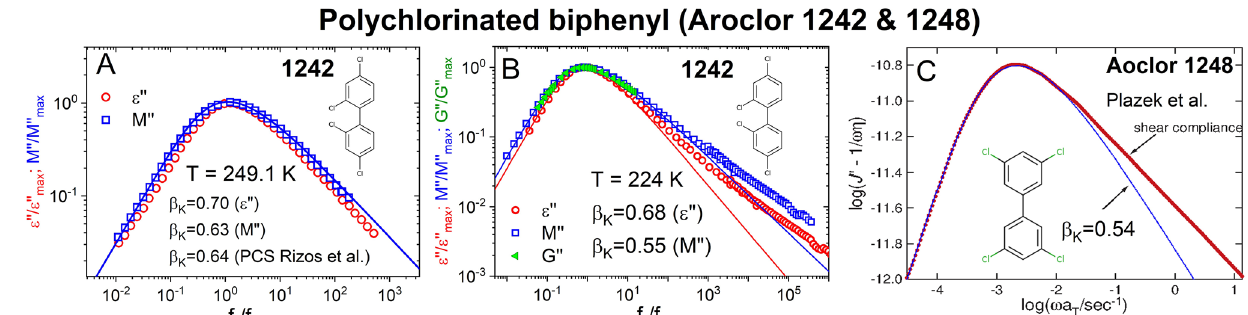
Figure 3. ( A ) Shows the normalized ε ″ ( f ) and M ″ ( f ) vs. normalized frequency of Aroclor 1242 at a higher temperature of 249.1 K. The exponents β DS K = 0.70 and β M K = 0.63 from the Kohlrausch fits are compare with β PCS K = 0.64 from PCS data from Rizos et al. 43 at about the same temperature. ( B ) Compares the frequency dispersions of the normalized ε ″ ( f ), M ″ ( f ) and G ″ ( f ) at a lower temperature of 224 K. The exponents from the Kohlrausch fits are β DS K = 0.68 for ε ″ ( f ), and β M K = 0.55 = β G K the same for M ″ ( f ) and G ″ ( f ). ( C ) Shows the imaginary part of the complex dynamic compliance (red line), J " − 1 /ωη , fitted by the Fourier transform of the J J G M Kohlrausch function with β K and β K = K = 0.54 (blue line) 42 . There is good agreement of β K = 0.54 with β β DS K = 0.68 at 224 K, and 0.70 at 249.1 K. The corresponding electric modulus M ″ ( f ) loss peak becomes broader as shown by comparing with ε ″ ( f ) after normalizing by the maxima and compensating the shift of M ″ ( f ) to higher frequencies. The values of β M K for M ″ ( f ) is 0.55 at 224 K, and 0.63 at 249.1 K (see Fig. 3A). Newly acquired shear modulus data of G ″ ( f ) at 224 K are included in the lower panel to show the α-frequency dispersion is the same as M ″ ( f ) and the Kohlrausch exponents β G K and β M K are equal to 0.55. Thus the broadening seen in G ″ ( f ) is explained by the decrease of the relaxation strength of the α-relaxation relative to the JG β-relaxation. Plazek et al. 42 made shear recovery compliance J r ( t ) measurements of Aroclor 1248 having a slightly higher molecular weight than Aroclor 1242 and T g two degrees higher. From the measurements, the complex dynamic compliance was computed. The imaginary part, J " − 1 /ωη , shown in Fig. 3C is fitted by the Fourier transform of the Kohl- rausch function with β J K = 0.54. The agreement of β J K = 0.54 with β G K and β M K = 0.53 indicates that mechanical spectroscopies (employing either the modulus or compliance modes) broaden the α-relaxation in the same way. PCS was performed by Rizos et al. 43 on Aroclor 1242 at temperatures near 249.1 K and higher but not at lower temperatures. The value of β PCS K reported is 0.64 and temperature independent, which is practically the same as 0.63 for β M K and we made this clear in Fig. 3. The agreement between β PCS K and β M K is like that found in Fig. 2 for PDE. It indicates that the broadening of the α-relaxation seen in dielectric permittivity when probed by PCS is due to a decrease of the relaxation strength of the α-relaxation relative to the unresolved JG β-relaxation close by, enabling the latter to broaden the frequency dispersion of the former. Tributyl phosphate (TBP). The family tributyl phosphate (TBP), triethyl phosphate (TEP), and triphenyl phos- phate (TPP) are highly polar glass-formers. TBP has Δε = 20 and narrow dielectric α-loss peak as shown in the upper panel of Fig. 4 and the Kohlrausch fit requires a large β DS K = 0.84 and similar values for the other members (shown in Fig. S1 for TEP and Fig. S2 for TPP) 21,22,44,45 . This property is like KDE, PDE, aroclor, and glycerol, as well as the other highly polar glass-formers 16,17 conforming to the correlation of β DS K with Δε found 15 . However unlike KDE, PDE, and glycerol, TBP and the other members have a prominent dielectric secondary γ-relaxation but it is not the JG β-relaxation, which is unresolved as suggested by the location of the primitive frequency f 0 at 146 K indicated by the arrow in the figure. This difference of TBP and other examples such as diethyl phthalate 36 , dibutyl phthalate 46 , and higher members. TBP and the others do not fall into the class of the so called “type A glass formers”, defined as liquids with dielectric spectra that do not display a discernible secondary relaxation peak (β-relaxation) at temperatures above T g 47 . Nevertheless, these polar glass-formers have larger β DS K and cor- relate with Δε as well. The comparison of the frequency dispersion of the α-loss peak from ε ″ ( f ) and M ″ ( f ) shows the reduction of the relaxation strength of the α-relaxation relative to the excess loss representing the unresolved JG β-relaxation as well as the resolved non-JG γ-relaxation. This is the cause for the broader α-loss peak in M ″ ( f ). In the lower panel of Fig. 4 we compare M ″ ( f ) with the susceptibility χ ″ ( f ) from PCS (or DLS) obtained by Pabst et al., which has β PCS K = 0.49 21,22 . There is excellent agreement in frequency dependence between M ″ ( f ) and χ ″ ( f ). Tripropylene glycol (TPG), methyl tetrahydrofuran (MTHF), diglycyl ether of bisphenol (DGEBA), tricresyl phos‑ phate (TCP), α‑phenyl o‑cresol. These polar glass-formers except TPG all have unresolved JG β-relaxation, and some like MTHF has a fast γ-relaxation. The values of Δε for TPG, MTHF, DGEBA, TCP, and α-phenyl o-cresol in decreasing order are 20, 18.6, 7, 5.6, and 3.4, respectively. These glass-formers are chosen because in addition to ε ″ ( f ) and M ″ ( f ) data either G ″ ( f ) or PCS data are available to compare with. The data shown in Panels A–F of Fig. 5 for TPG 48 , MTHF 34 , DGEBA 49 , TCP 50 , and α-phenyl o-cresol 50 . The smaller value β M K = 0.41 than β G K = 0.48 of TPG is explained by lesser sensitivity of shear modulus than electric modulus. The PCS data of MTHF, TCP,